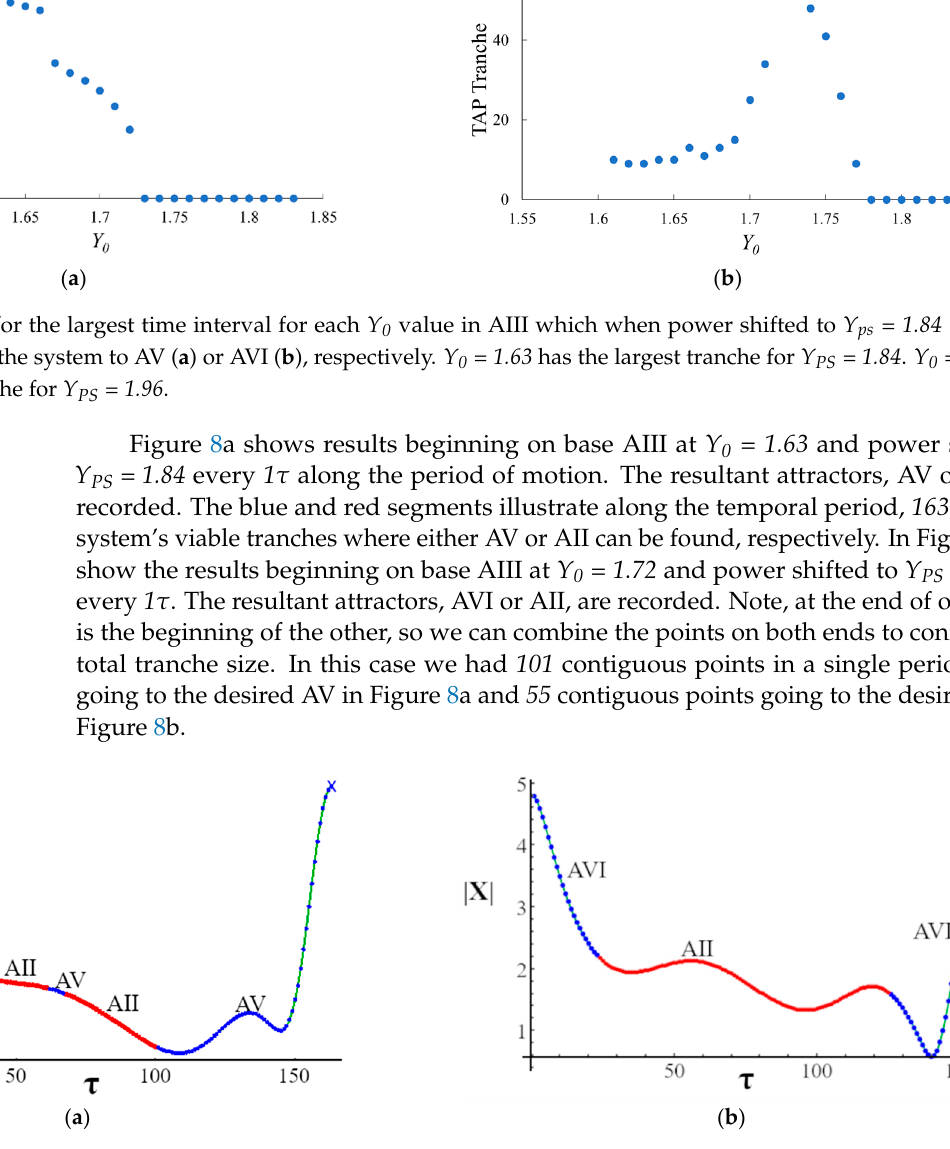
Figure 8. Power-shift method from AIII at ( a ) Y 0 = 1.63 transitioning to coexisting AII and AV via Y PS = 1.84 , and ( b ) Y 0 = 1.72 transitioning to coexisting AII and AVI via Y PS = 1.96.